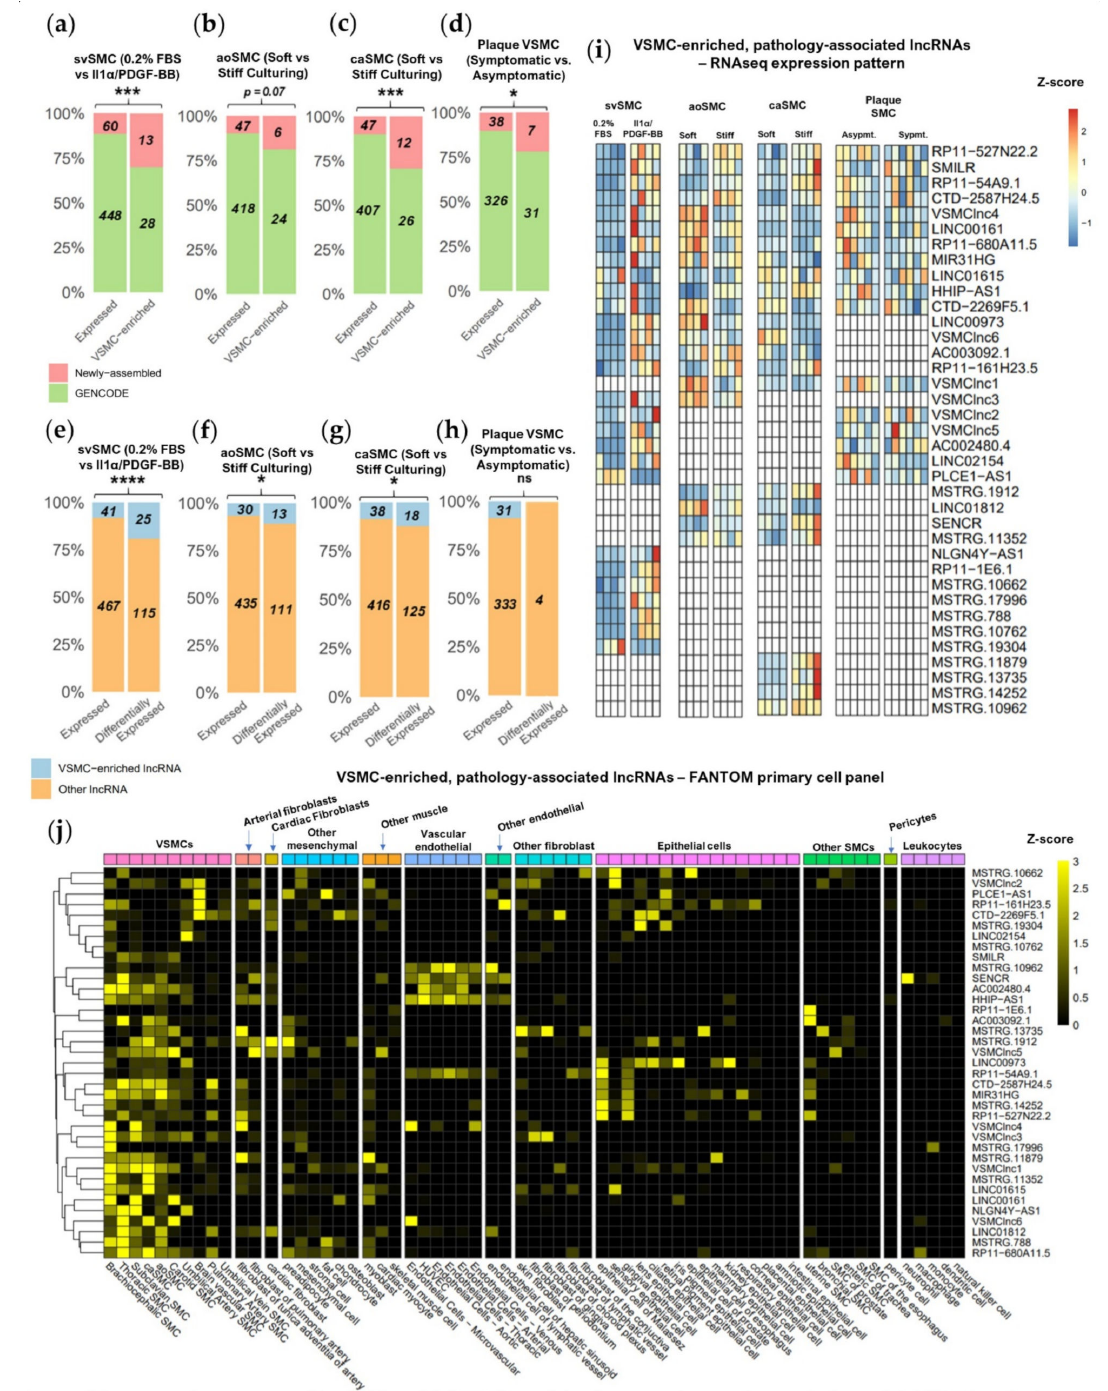
Figure 3. Increased coverage of lncRNAs with VSMC-enriched expression and association with VSMC pathology. ( a – d ) Proportion of newly assembled vs. GENCODE lncRNAs within CAGE-matched lncRNAs and CAGE-matched, VSMC-enriched lncRNAs. ( e – h ) Proportion of VSMC-enriched or non VSMC-enriched lncRNAs that are expressed or differentially expressed (Fisher’s exact test for ( a – h ), background of CAGE-matched lncRNAs). ( i ) Expression heatmap of all 37 VSMC-enriched and differentially expressed lncRNAs responding to IL-1 α /PDGF-BB or stiff culturing as well as within plaque VSMCs (Z score generated for each VSMC type individually, white cells indicate no robust expression). ( j ) Expression heatmap of all 37 VSMC-enriched and differentially expressed lncRNAs across vascular cell types and other relevant cell types in the FANTOM CAGE expression atlas. ( a – h ) p < 0.0001 ****, p < 0.001 ***, p < 0.05 *, ns not